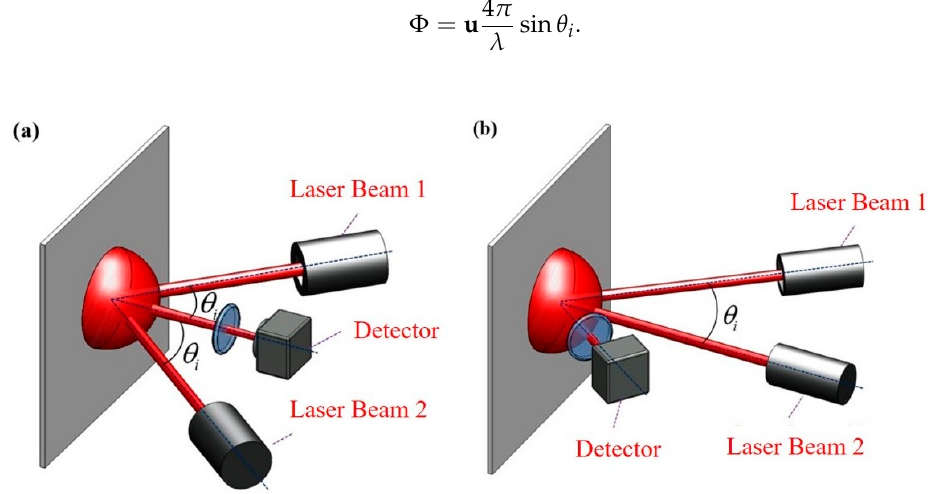
Figure 2. ( a ) Symmetrical speckle interferometry; ( b ) Asymmetric speckle